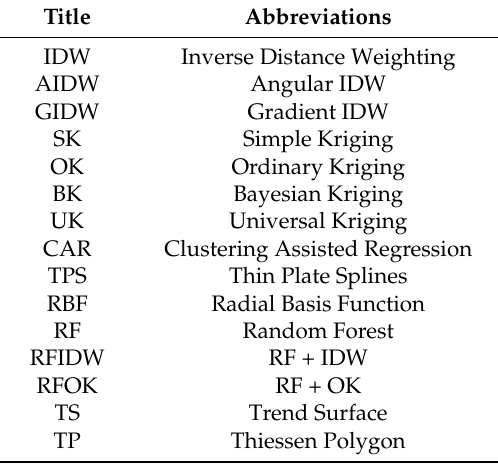
Table 2. Abbreviation list of the interpolation techniques used in Table